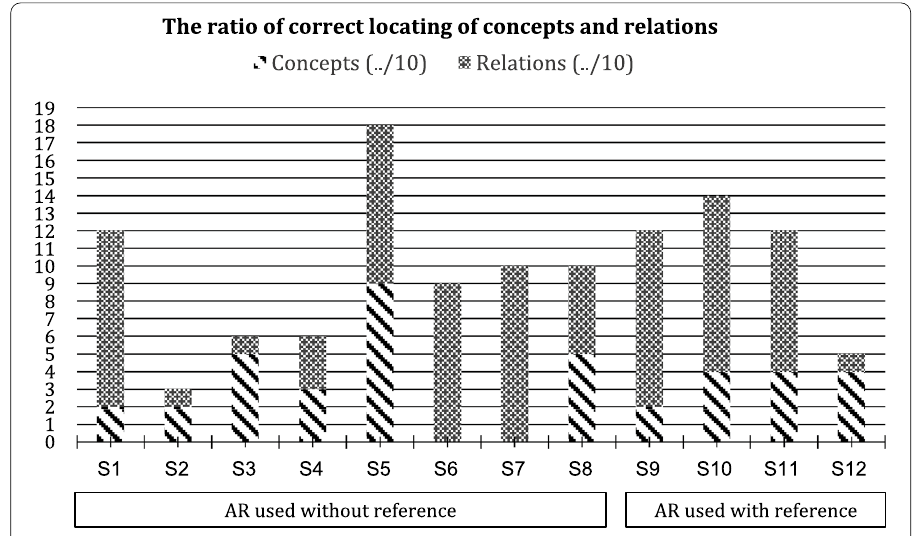
Fig. 4 The performance scores in locating concepts and